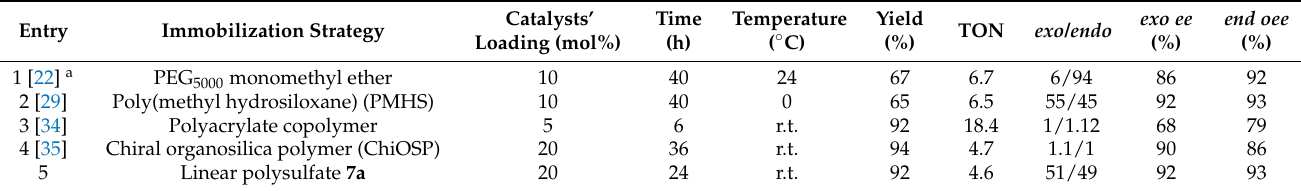
Table 7. Comparisons of various soluble polymeric MacMillan catalysts for asymmetric Diels–Alder reaction between ( E )-cinnamaldehyde and